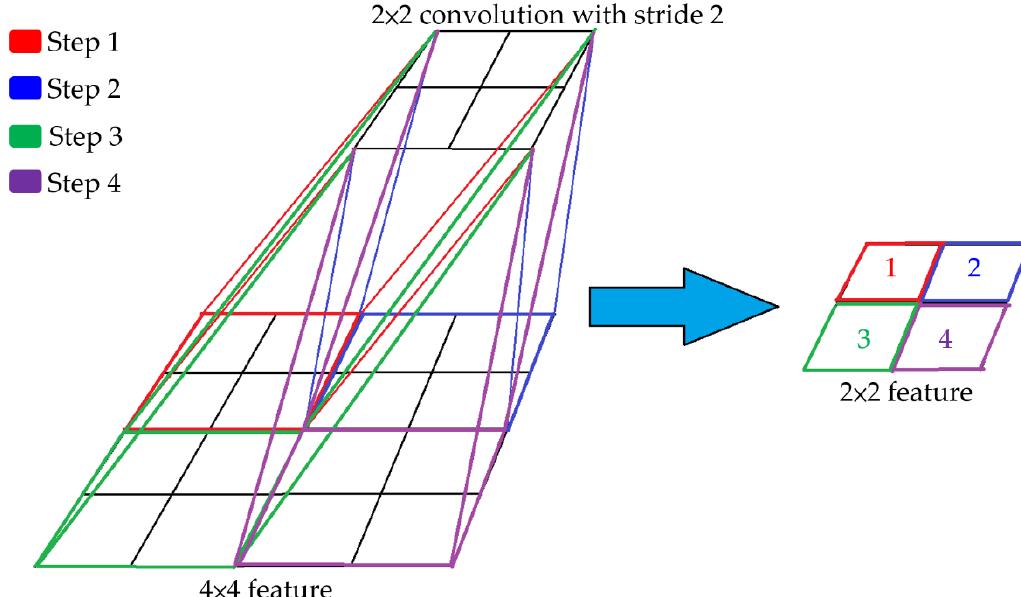
Figure 6. Convolution with a 2 × 2 kernel using convolutional stride 2 work on a 4 × 4 feature map.